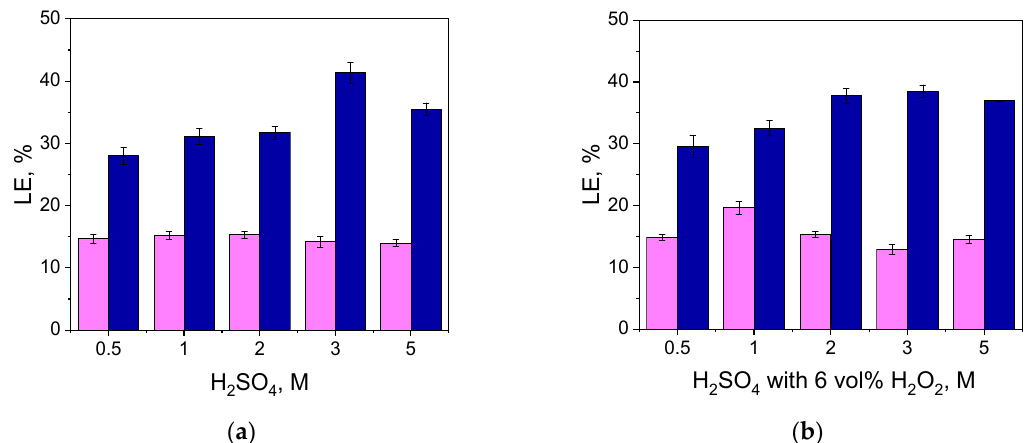
Figure 2. Efficiency of Co(II) ( ) and Mo(VI) ( ) leaching from spent industrial catalyst with ( a ) sulfuric acid solutions, ( b ) sulfuric acid solutions with addition of 6 vol% of 30% H 2 O 2 (50°C, S/L = 1/20 g/cm 3 , particle size of catalyst <45 µm, stirring 300 rpm).